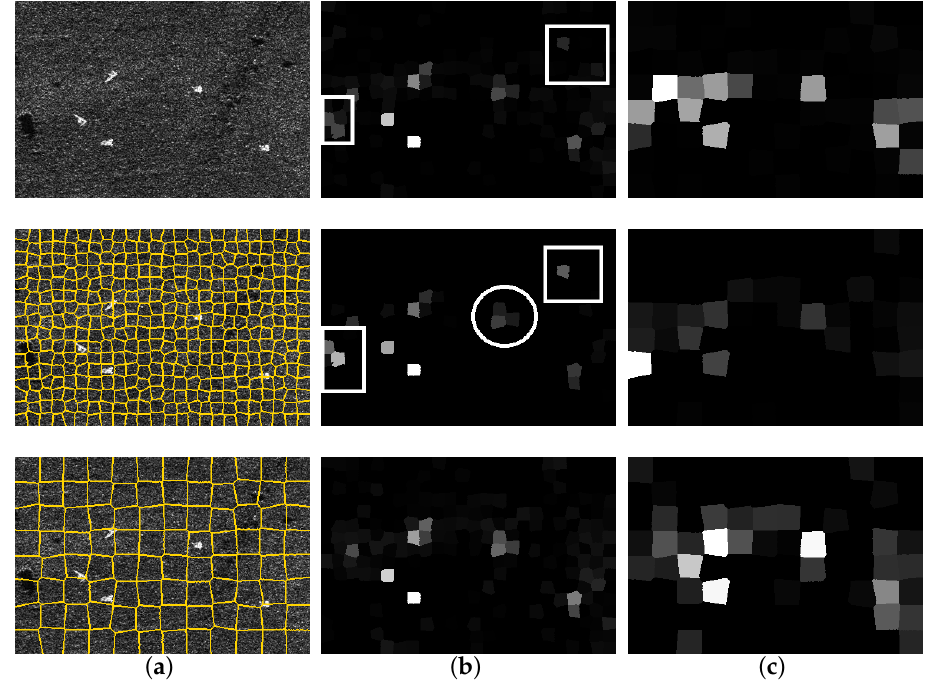
Figure 4. Outlier detection of different size superpixels. ( a ) Simulation of SAR image, and superpixel segmentation results when size parameters W = 16 and W = 32; ( b ) The outlier degree of self information, relative entropy and conditional entropy of with W = 16; ( c ) The outlier degree of self information, relative entropy and conditional entropy with W =